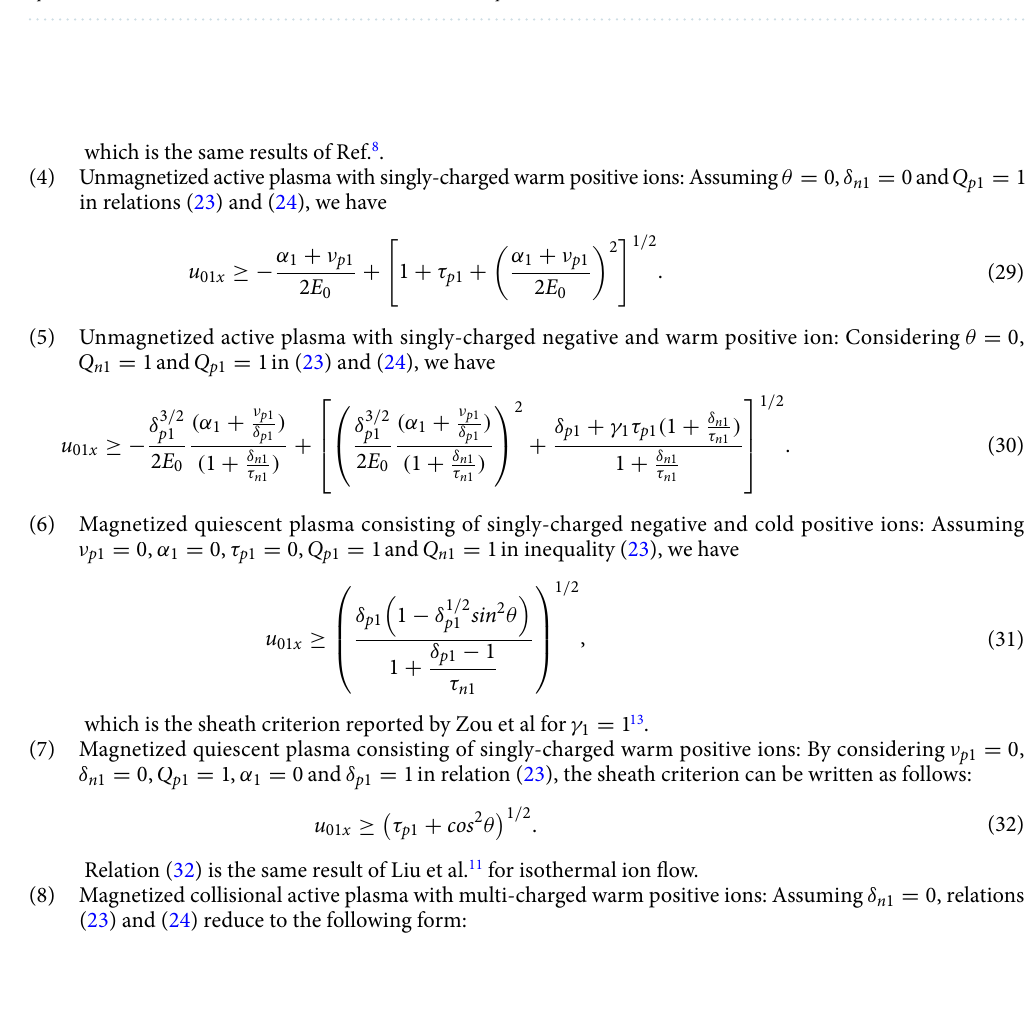
Figure 1. Variation of the normalized density distribution of the charged particles toward the wall for ν p 1 = 0, ρ = 0, u 01 x = 0.774 (dotted-dashed line), ν p 1 = 0, ρ = 0.01, u 01 x = 0.72 (dotted line), ν p 1 = 0.005, ρ = 0, u 01 x = 0.774 (dashed line) and ν p 1 = 0.005, ρ = 0.01, u 01 x = 0.72 (solid